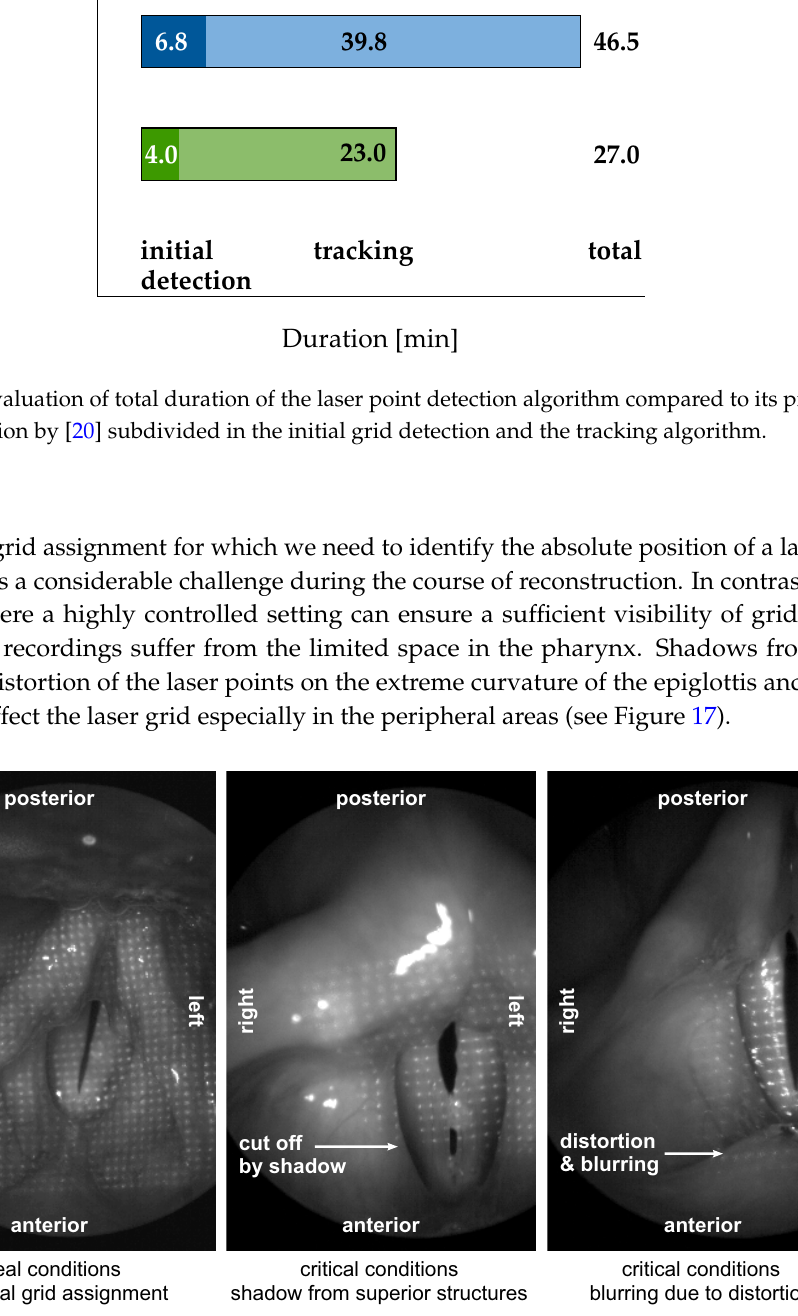
Figure 17. Uncontrollable conditions for global grid assignment in in vivo recordings due to shadows or distortions of the grid points on pharynx